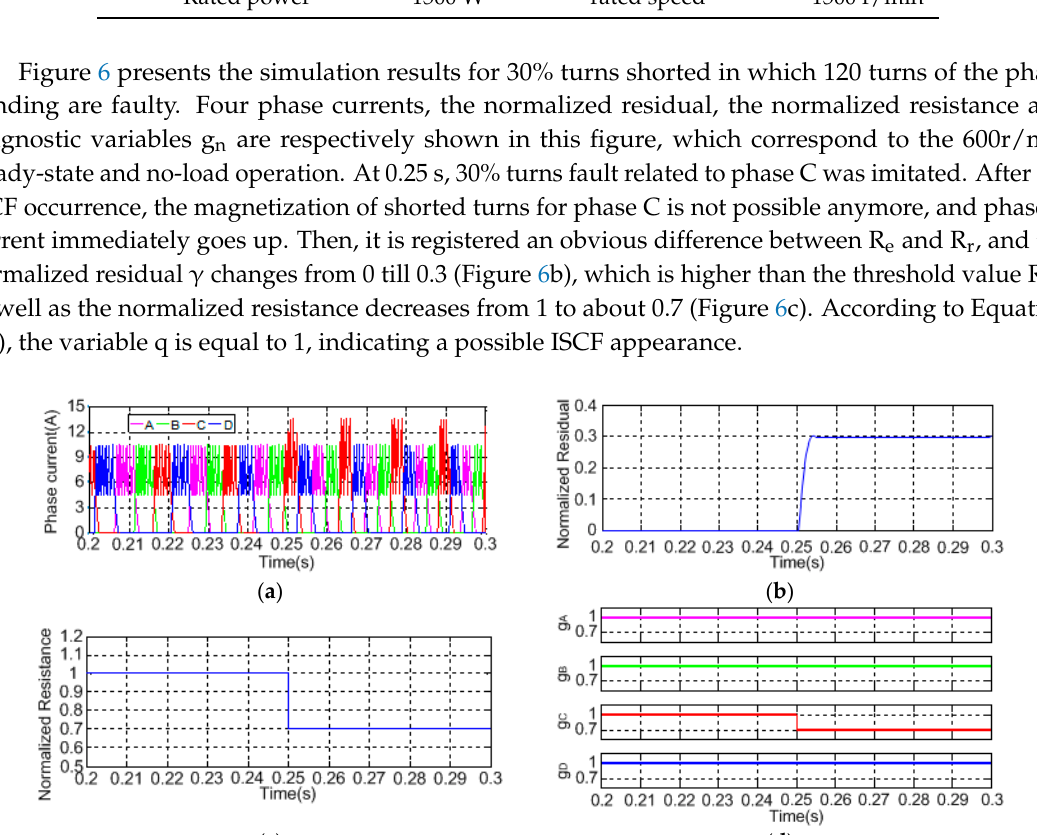
( d ) Figure 7. Simulation results in case of multiphase ISCF with high speed and variable loading. ( a ) four-phase currents; ( b ) normalized residual; ( c ) normalized resistance; and ( d ) diagnostic variable g n .